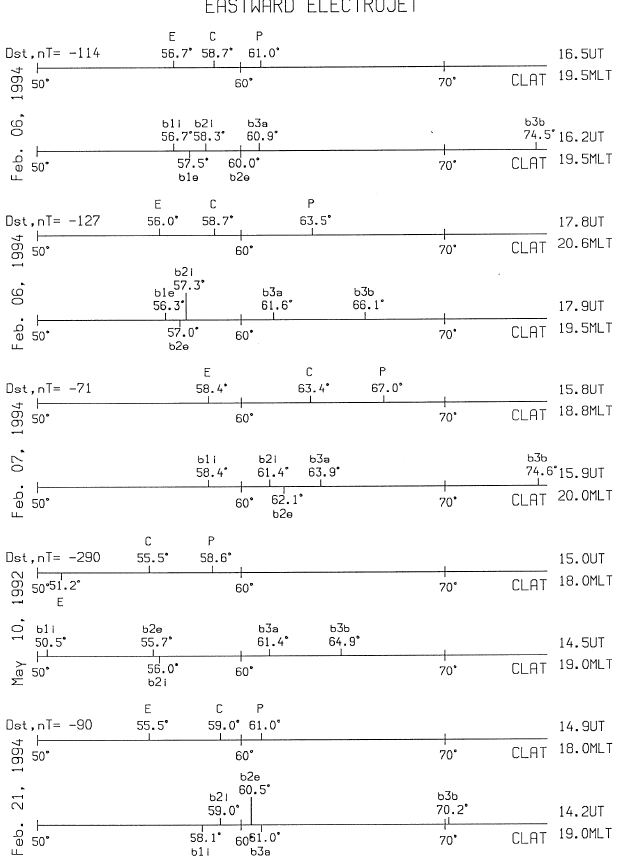
Fig. 5. The center ( C ) and boundaries ( E , equatorial and P , polar) of eastward electrojets in the course of magnetic storms on February 06– 07, February 21, 1994 and May 10, 1992 in the evening sector. For DMSP F08 and DMSP F10 passes with UT and MLT crossing close to electrojets the location of plasma domain boundaries according to Newell et al. (1996) is presented: b1e , i , are boundaries of ‘‘zero – energy’’, usually determined by the softness channels; b2e are points where electron average energy is neither increasing nor decreasing with latitude; b 2 i is precipitating ion energy flux maximum; b 3 a is the most equatorward electron acceleration event identified, equatorial boundary of the structural auroral forms; b 3 b is the most poleward such event, polar boundary of the discrete auroral forms. Hourly mean Dst values correspond to UT